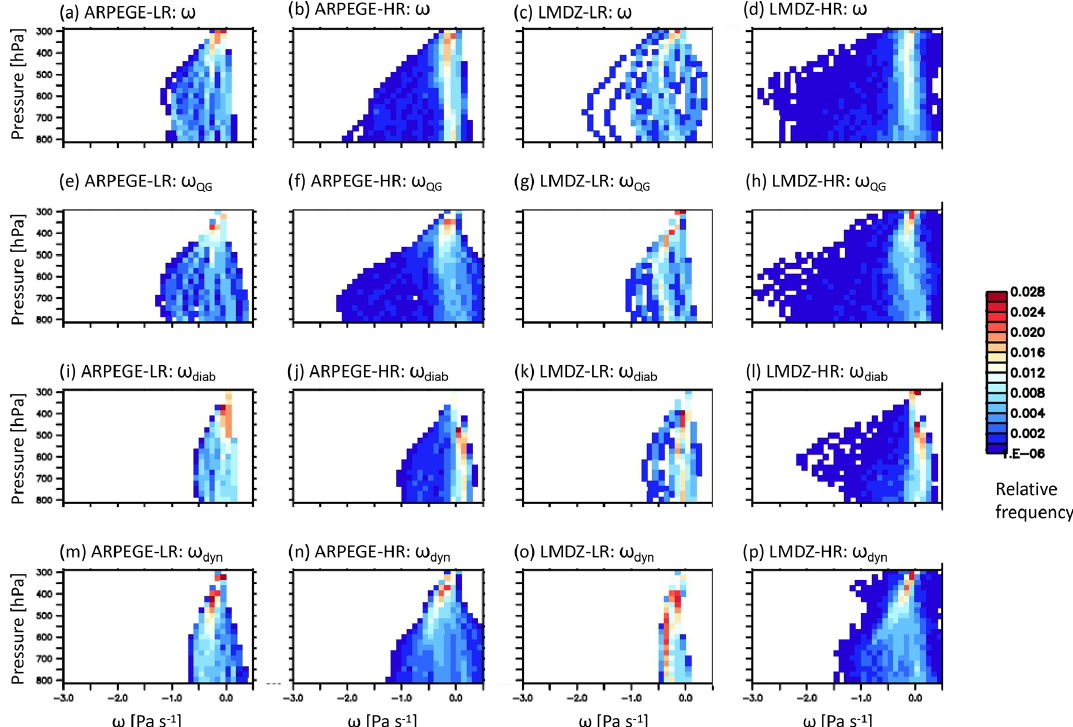
Figure 9. Bivariate histograms of vertical velocity vs. pressure in a 6 ◦ × 6 ◦ box around the minimum pressure during the mature stage of the cyclone around maximum depth (ca. 12:00UTC 2 October 2016; T + 33–36h) for (a–d) modelled ω , (e–h) ω QG , (i–l) ω diab , and (m–p) ω dyn and for (a, e, i, m) ARPEGE-LR, (b, f, j, n) ARPEGE-HR, (c, g, k, o) LMDZ-LR, and (d, h, l, p) LMDZ-HR. The colour scale applies to all plots. The hindcasts were initiated at 00:00UTC 1 October